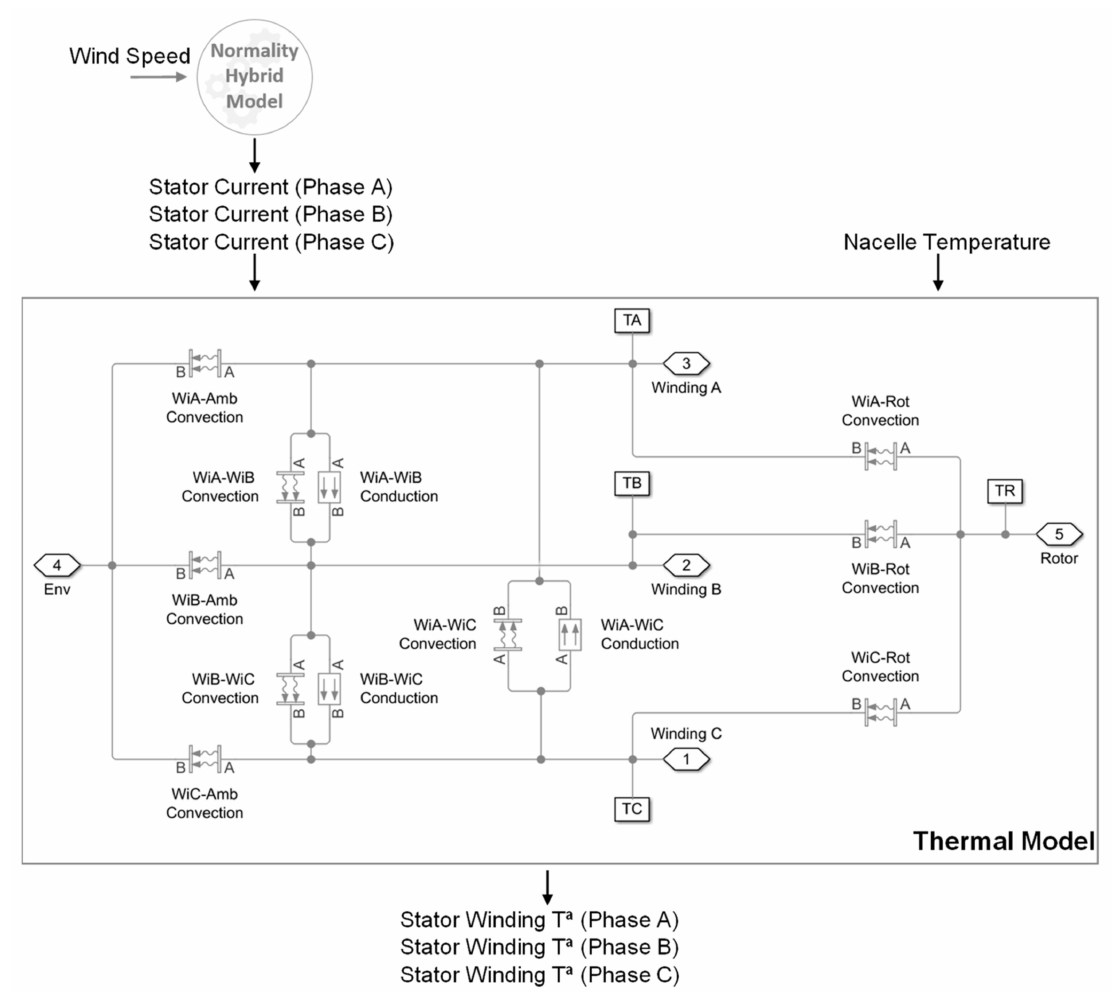
Figure 11. Thermal circuit of stator